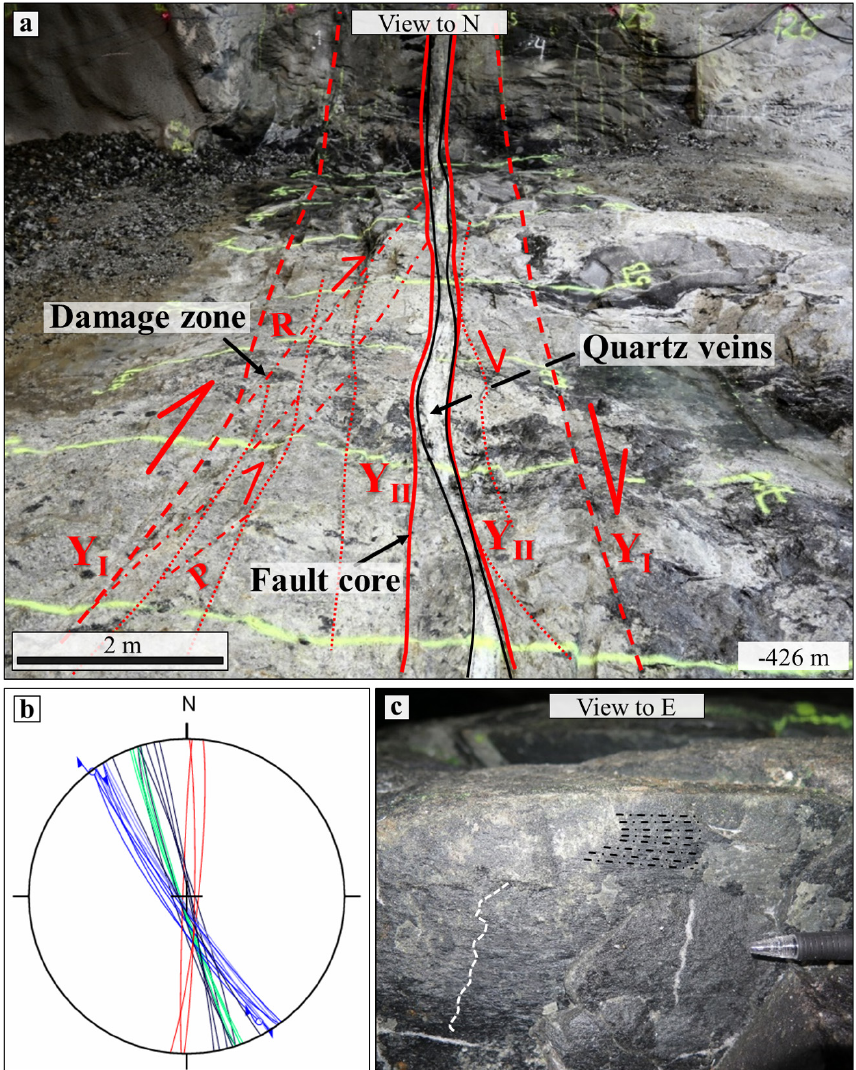
Figure 2. (a) View to the north and interpretation of the structural elements of BFZ300. (b) Lower hemisphere, equiangular projection of conjugate fault segments (blue: dextral faults; red: sinistral faults), cleavage (green), and Qtz I chlorite veins infilling joints (black). (c) Slickensides (white dashed line) and slickenlines (black dashed lines) on a chlorite-decorated, NW–SE-striking fracture plane at the vein–host interface, indicating dextral strike–slip